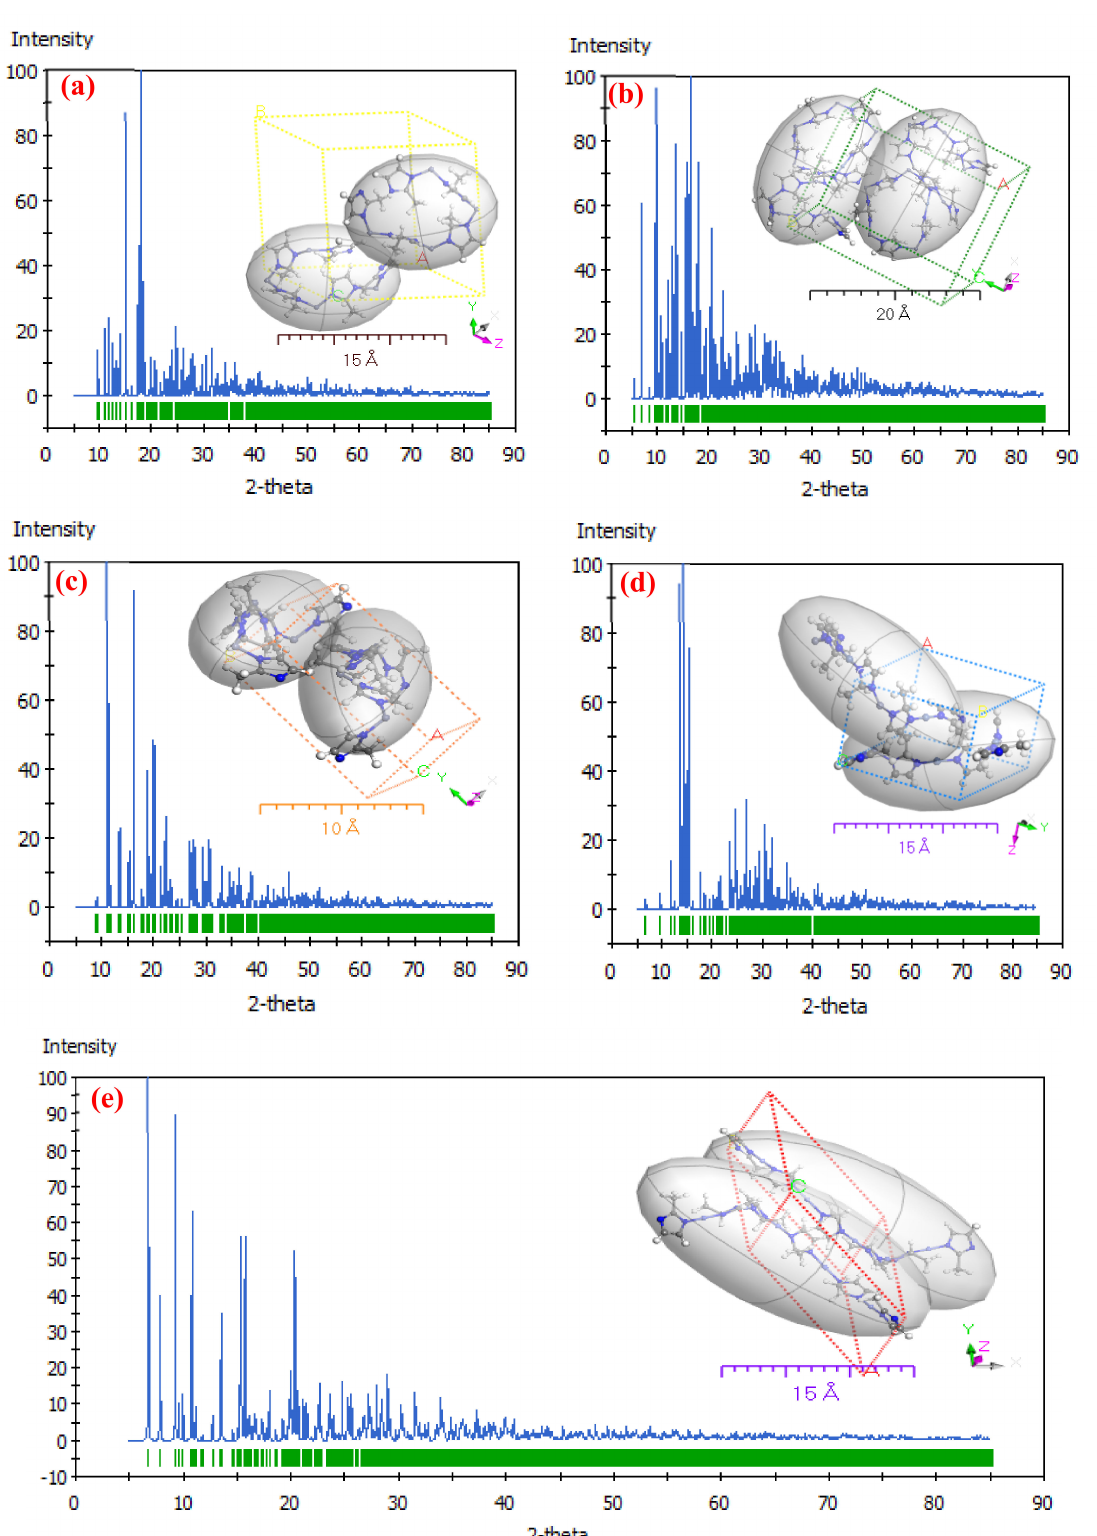
Figure 8. ( a – e ): The simulated XRD patterns attained by using the TDDFT method of Zn x Co 1-x -ZIF-8; the inset Figure is the lattice type: a 3D molecule attained by using the Polymorph computation